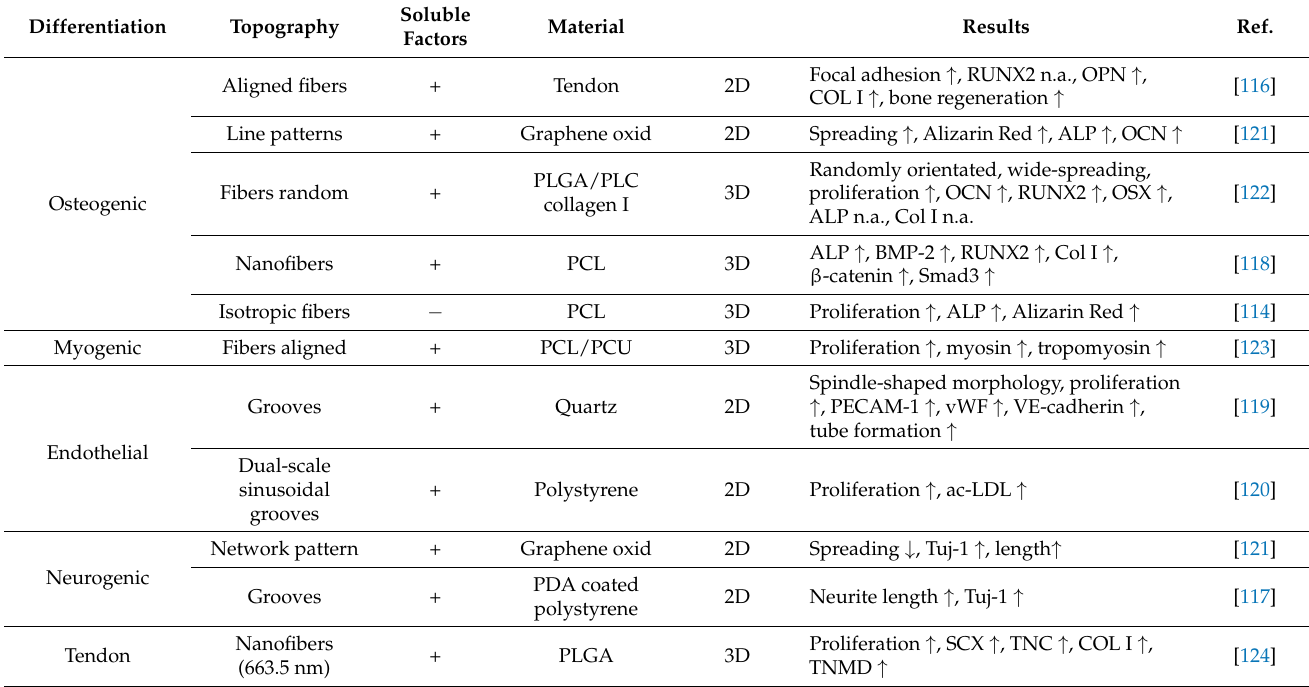
Table 2. Overview of the influence of grooved and nanofiber topography on ASC differentia- tion. (PDA: polydopamine, PLGA: polylactide-co-glycolide (PLGA), PCL: poly caprolactone, PU: